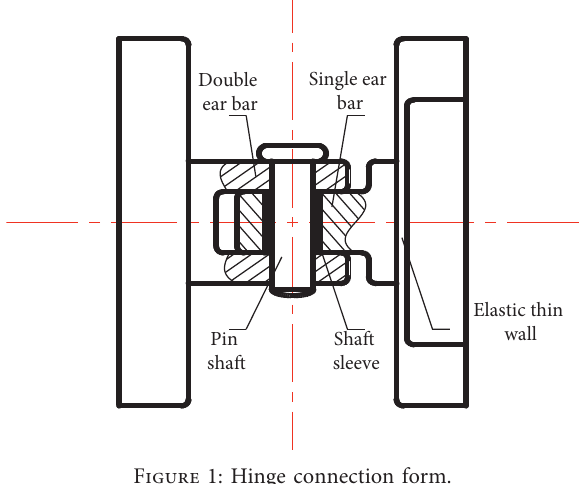
Figure 1: Hinge connection form.